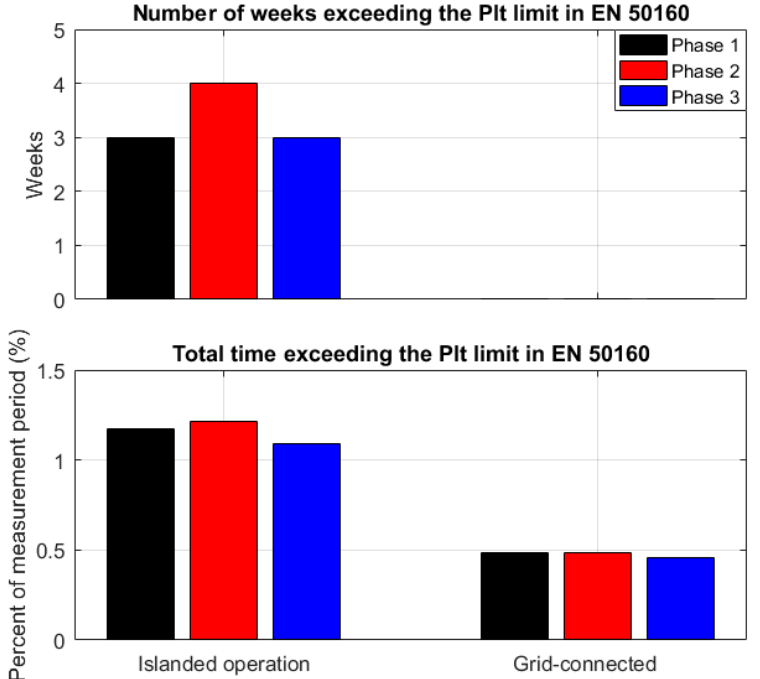
Figure 25. The number of times the Plt values exceeded the limits in EN 50160 ( top ) and the amount of time during the measurement period of 48 weeks in which the Plt values exceeded the limits in EN 50160 ( bottom ) for islanded